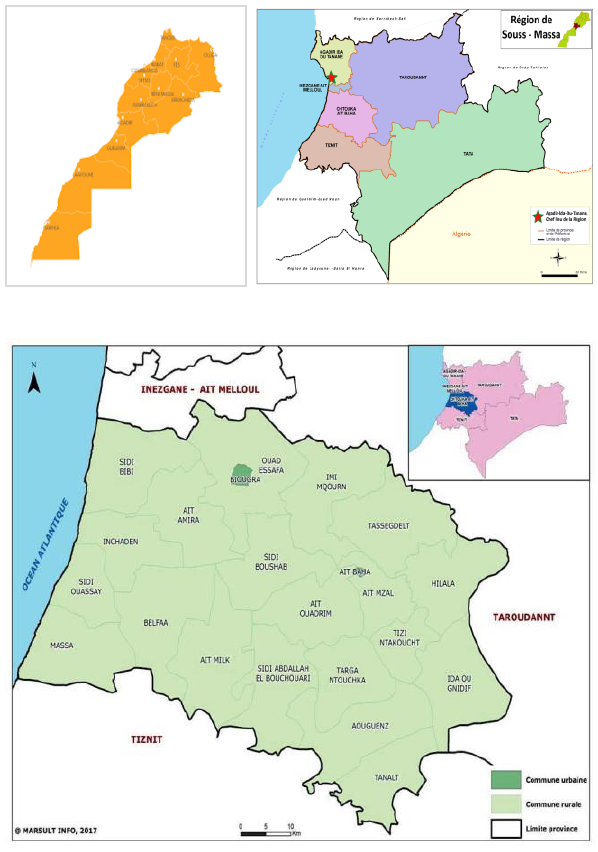
Figure 1 . The geographical situation of Biougra city.